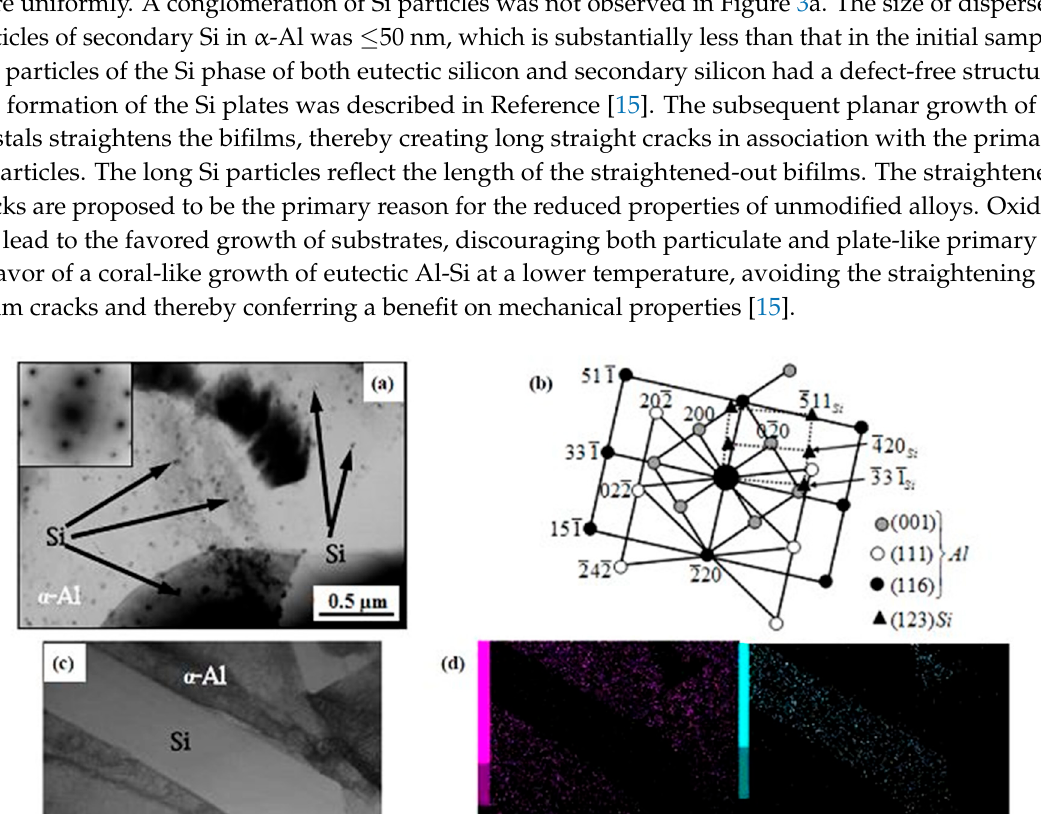
Figure 2. Transmission electron microscopy (TEM) image of the initial А l-7%Si alloy: ( a ) a bright-field image and its microdiffraction pattern; ( b ) an indexed scheme of section ( a ).